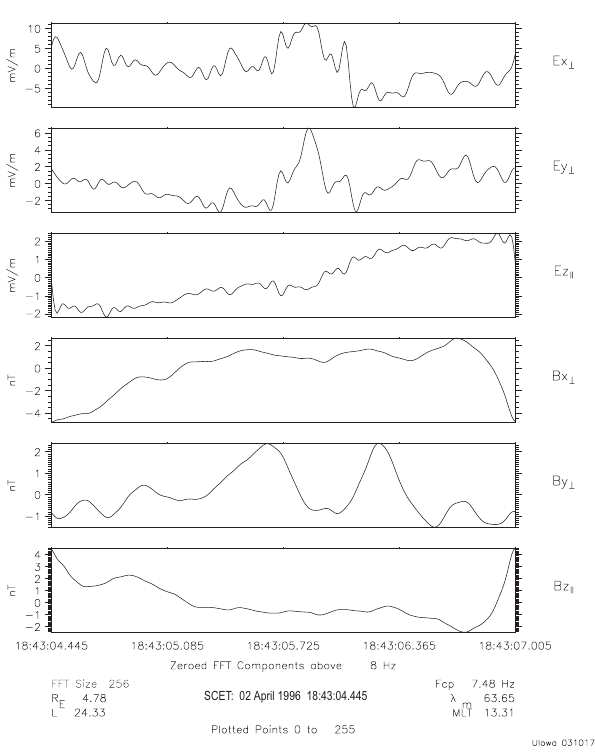
Fig. 2a. The waveform from the PWI LFWR on board the Polar spacecraft. This figure shows the 3 electric and 3 magnetic field measurements in field-aligned coordinates, and extends over a time interval of about 2.56s. The fields have been filtered for frequencies below about 8Hz. The proton cyclotron frequency at this time is about 7.7Hz. Note the rather large electric fields reflected in the first two panels where the electric field is perpendicular to the ambient magnetic field, which we believe are signatures of an Alfv´en wave.